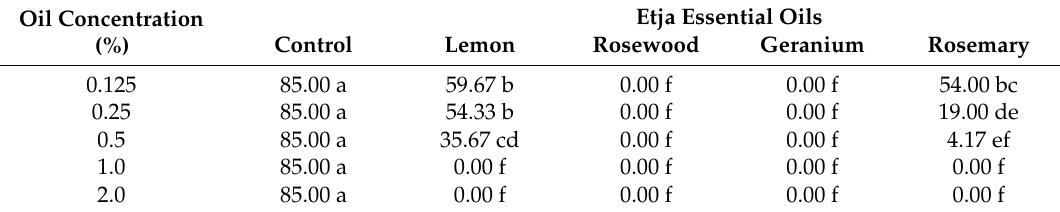
Table 4. The index of linear growth (T) of Fusarium graminearum ZALF